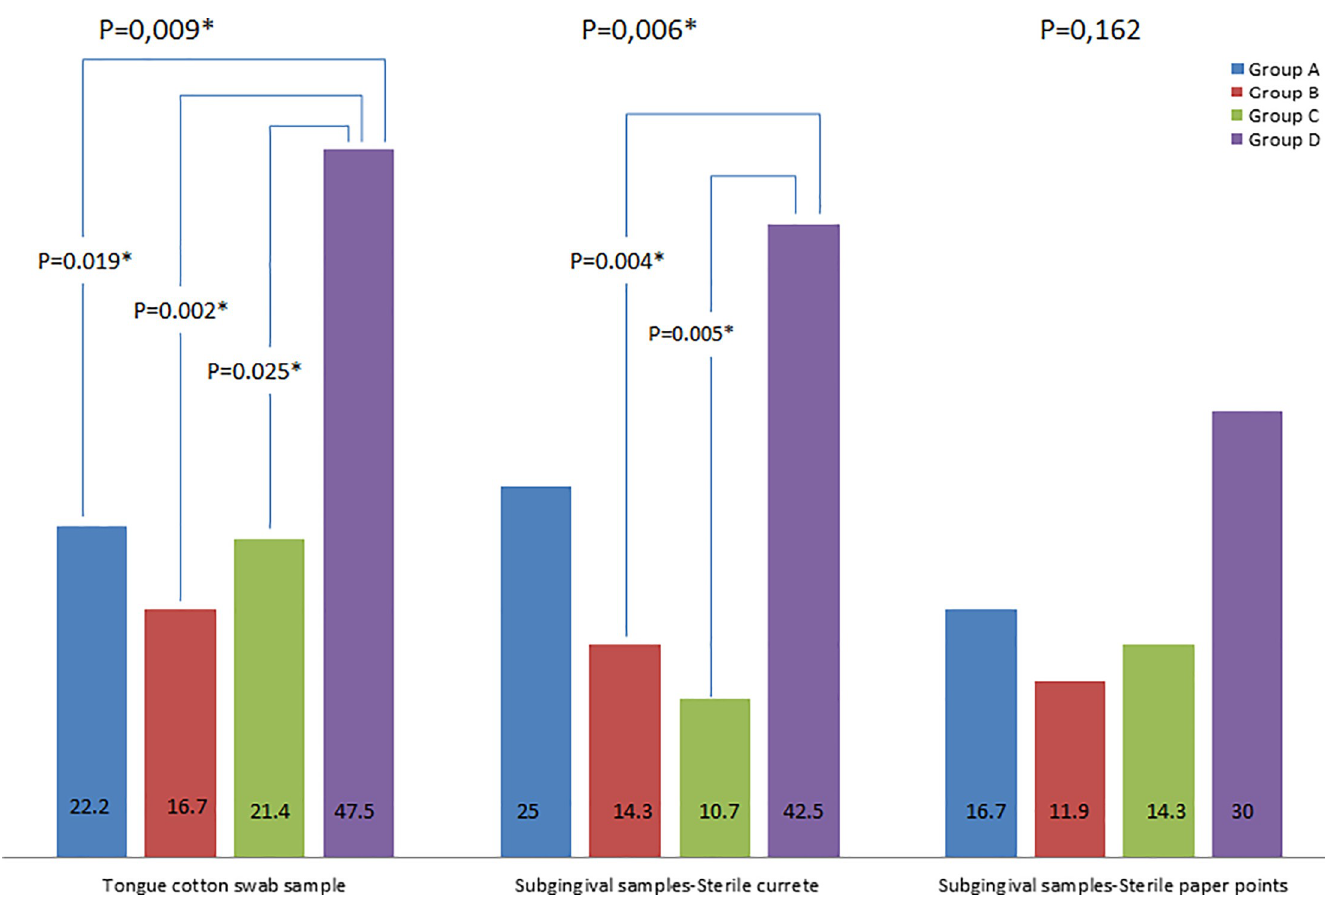
Fig 2. Positive findings of Candida spp. on tongue and in subgingival areas (presented as %). � presents statistical significant difference (p < 0.05).